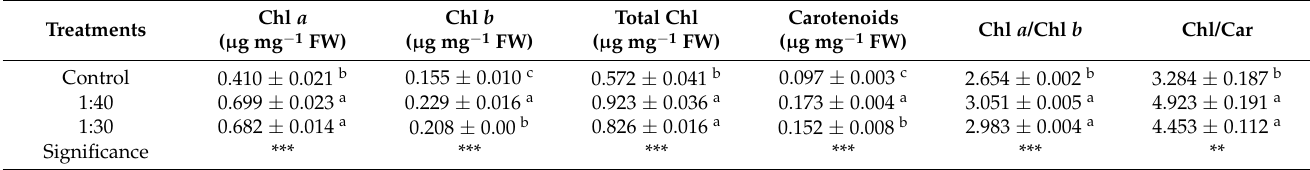
Table 3. Effect of Moringa oleifera leaf extract (MLE) foliar application on chlorophyll a and b content, chlorophyll a / b ratio (Chl a /Chl b ), total chlorophyll, carotenoid content, and chlorophyll/carotenoids ratio (Chl/Car) of radish baby leaf. MLE extract was sprayed 15 and 30 days after planting and 2 days before harvesting (45 days after planting).